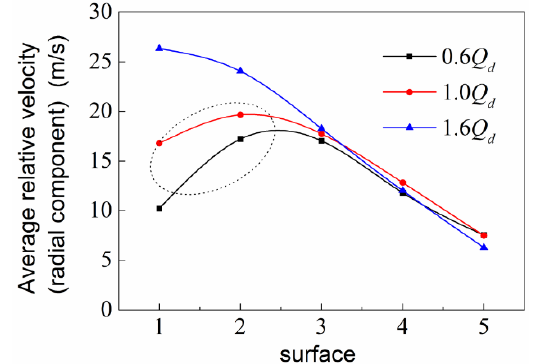
Figure 14. Average relative velocity of monitoring surfaces.